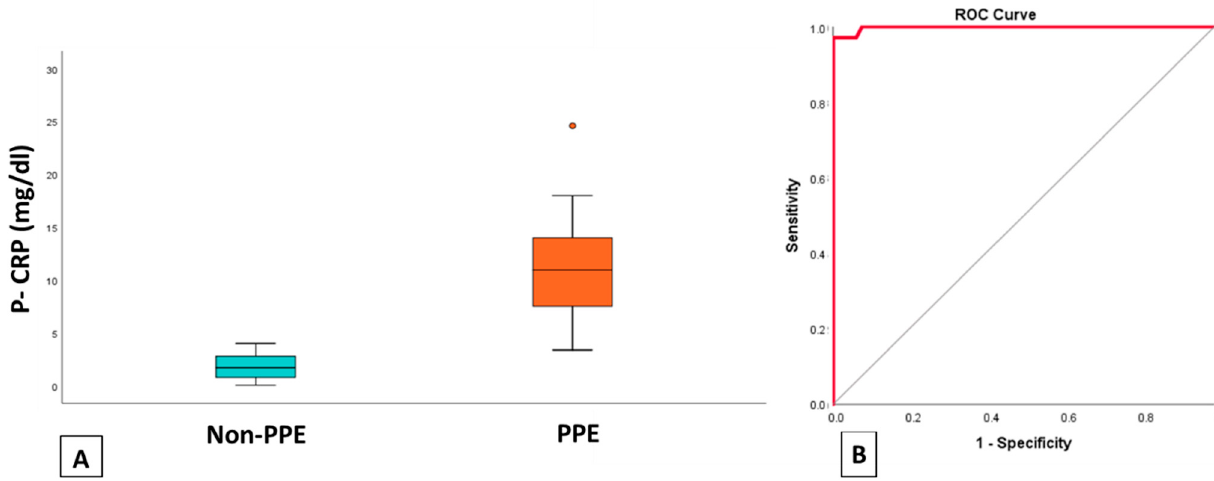
Figure 2. ( A ) Boxplot of p-CRP levels of PPE and non-PPE. ( B ) ROC curve of CRP levels for differentiating parapneumonic pleural effusions from other types of pleural effusions. PPE: Parapneumonic pleural effusions, p-CRP: pleural C-Reactive protein.